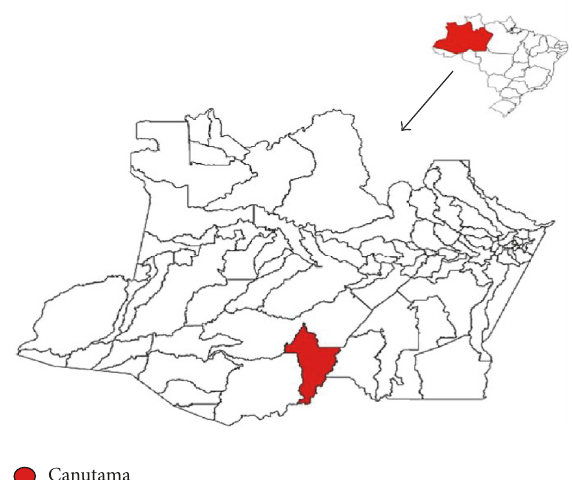
Figure 1: Study area . The map of the State of Amazonas (bottom), in Brazil (top right corner), shows the municipality of Canutama in